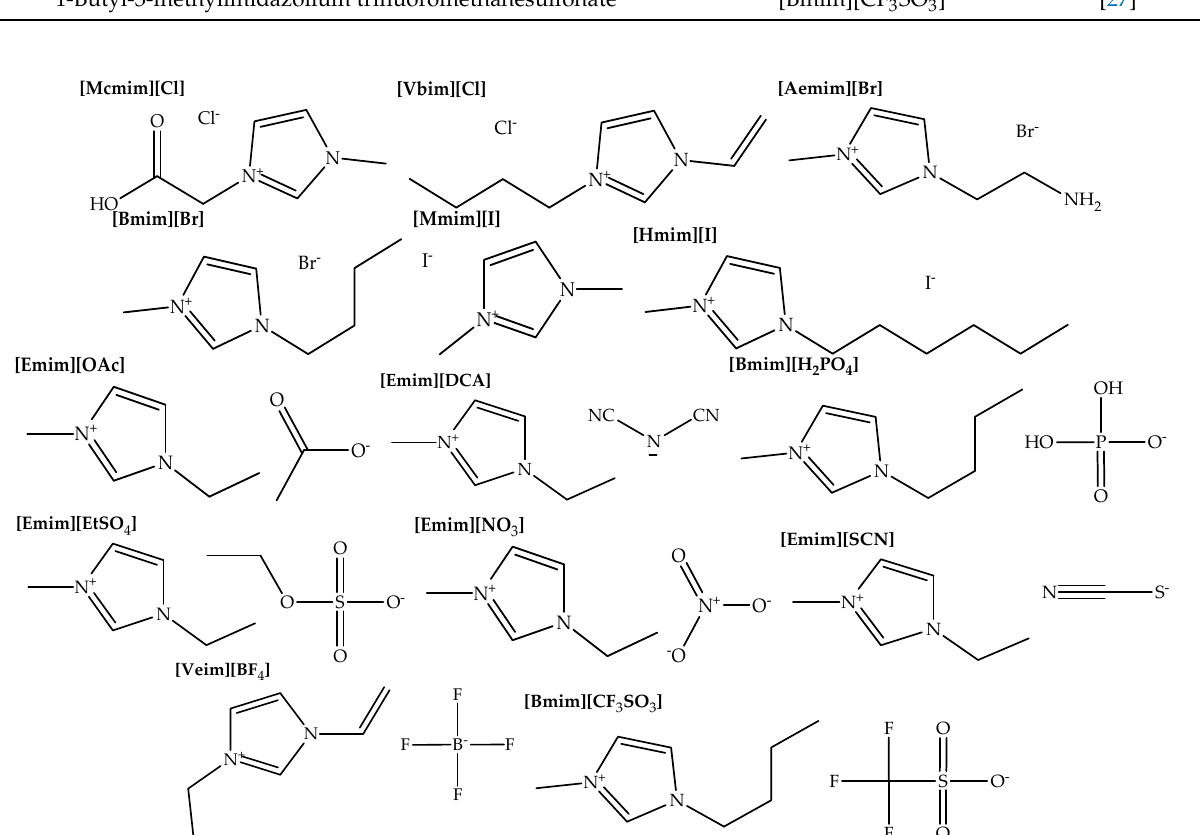
Figure 3. Chemical structures of hydrophilic imidazolium-based ionic liquids and the abbreviations are explained in Table 1. Table 2. Examples of hydrophobic imidazolium-based ionic liquids utilized for preparation of PVDF and PVDF-HFP blends and composites.